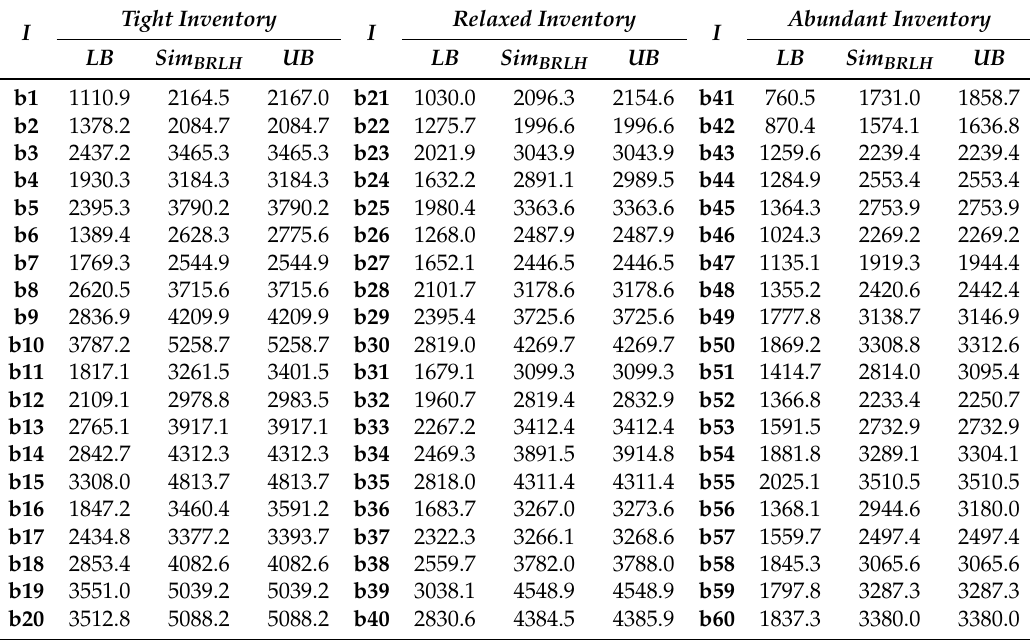
Table 6. Analysis of the results obtained by our Sim BRLH on scenarios of tight, relaxed and abundant